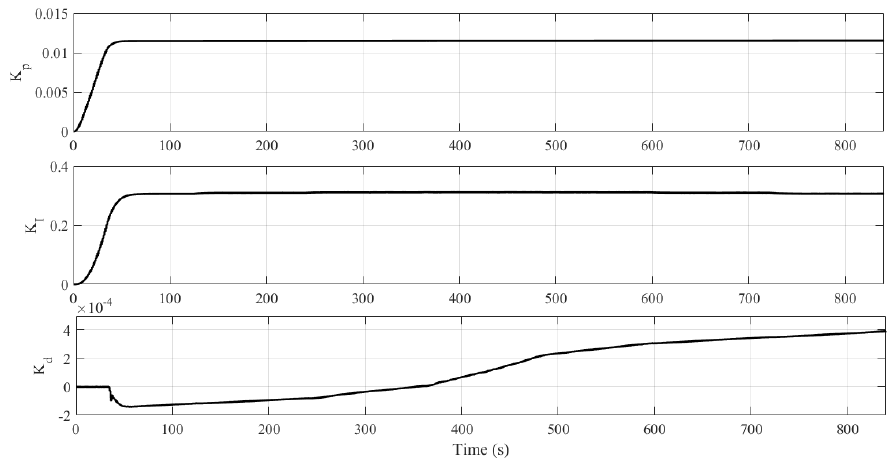
Figure 10. Controller parameters (Experiment